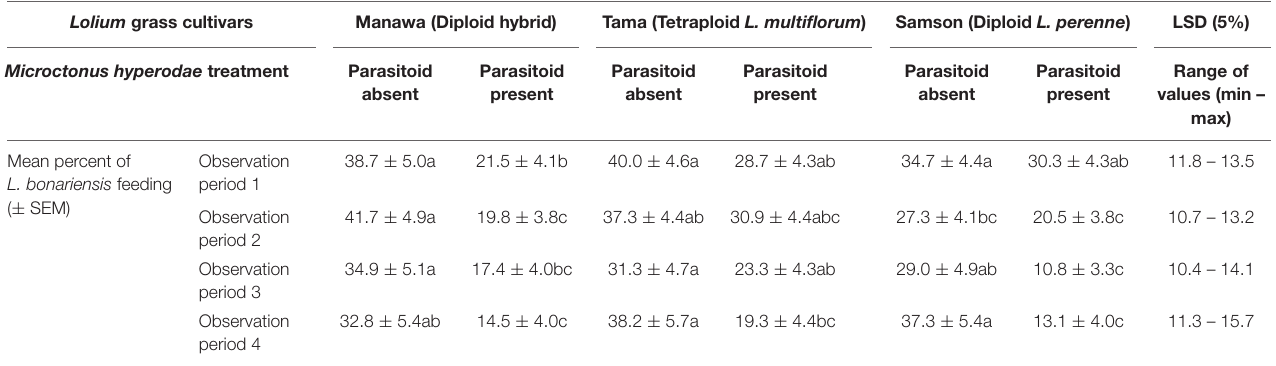
Parasitoid Parasitoid Parasitoid Parasitoid Parasitoid Range of absent present absent present absent present values (min – max)